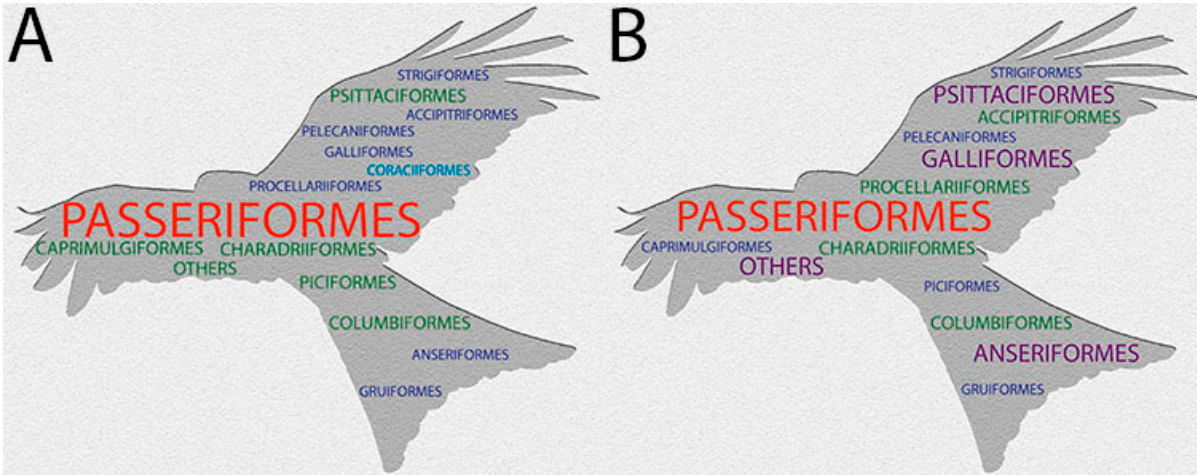
Figure 1. This word cloud (Wordart.com; accessed 25 March 2021) represents: ( A ) the proportion of the 10,721 avian species in 41 avian [14] orders. For brevity, 24 orders constituting less than 1% of avian diversity are combined into “others”; ( B ) the number of species detected with APV in each order. Orders are color-coded to represent the percentage of avian species found/cases of APV detected in each order, where blue and small represents <3%, green 3–7.5%, purple 7.5–11%, and red and large >11%. Although APV has been detected in more Passeriformes species than non-Passeriformes species, more APV are detected in non-Passeriformes than in Passeriformes. Coraciiformes (light blue in ( A ), missing from ( B )) contains 1.7% of avian species, though APV has not yet been detected in this order.